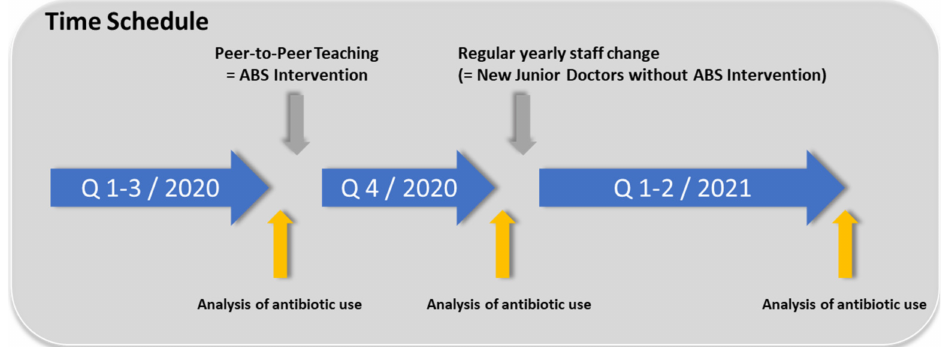
Figure 3. Time schedule of the ABS